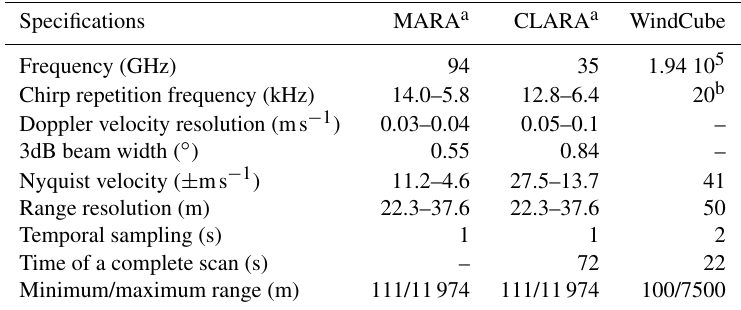
Table 1. Technical specifications and settings of the lidar and cloud radars operated during CMTRACE.